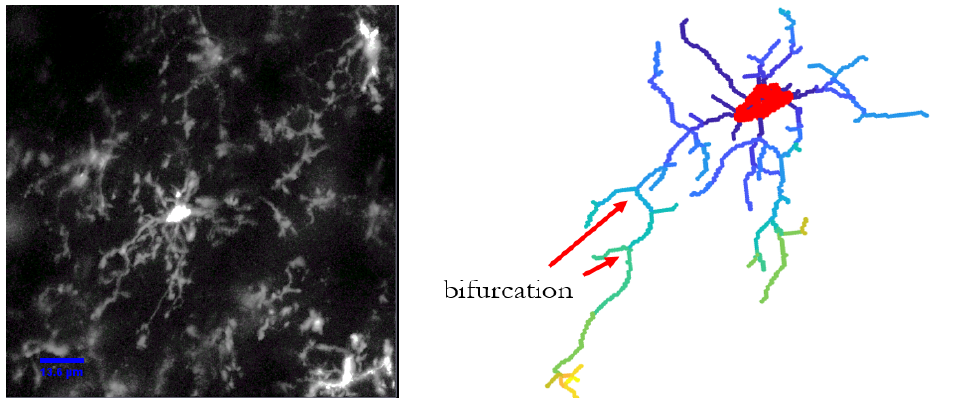
Figure 12. The path hierarchy is depicted by the different colors. The paths hierarchy at each node is determined by the number of bifurcations that are crossed when traversed back to the